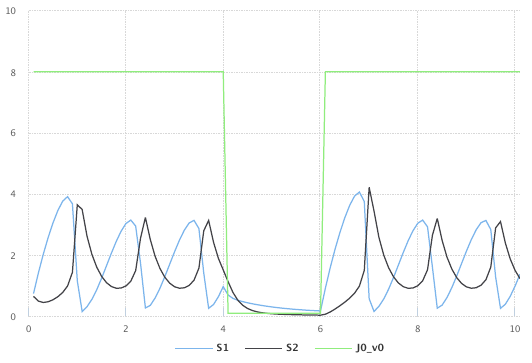
Figure A.10: Simulation with tellurium